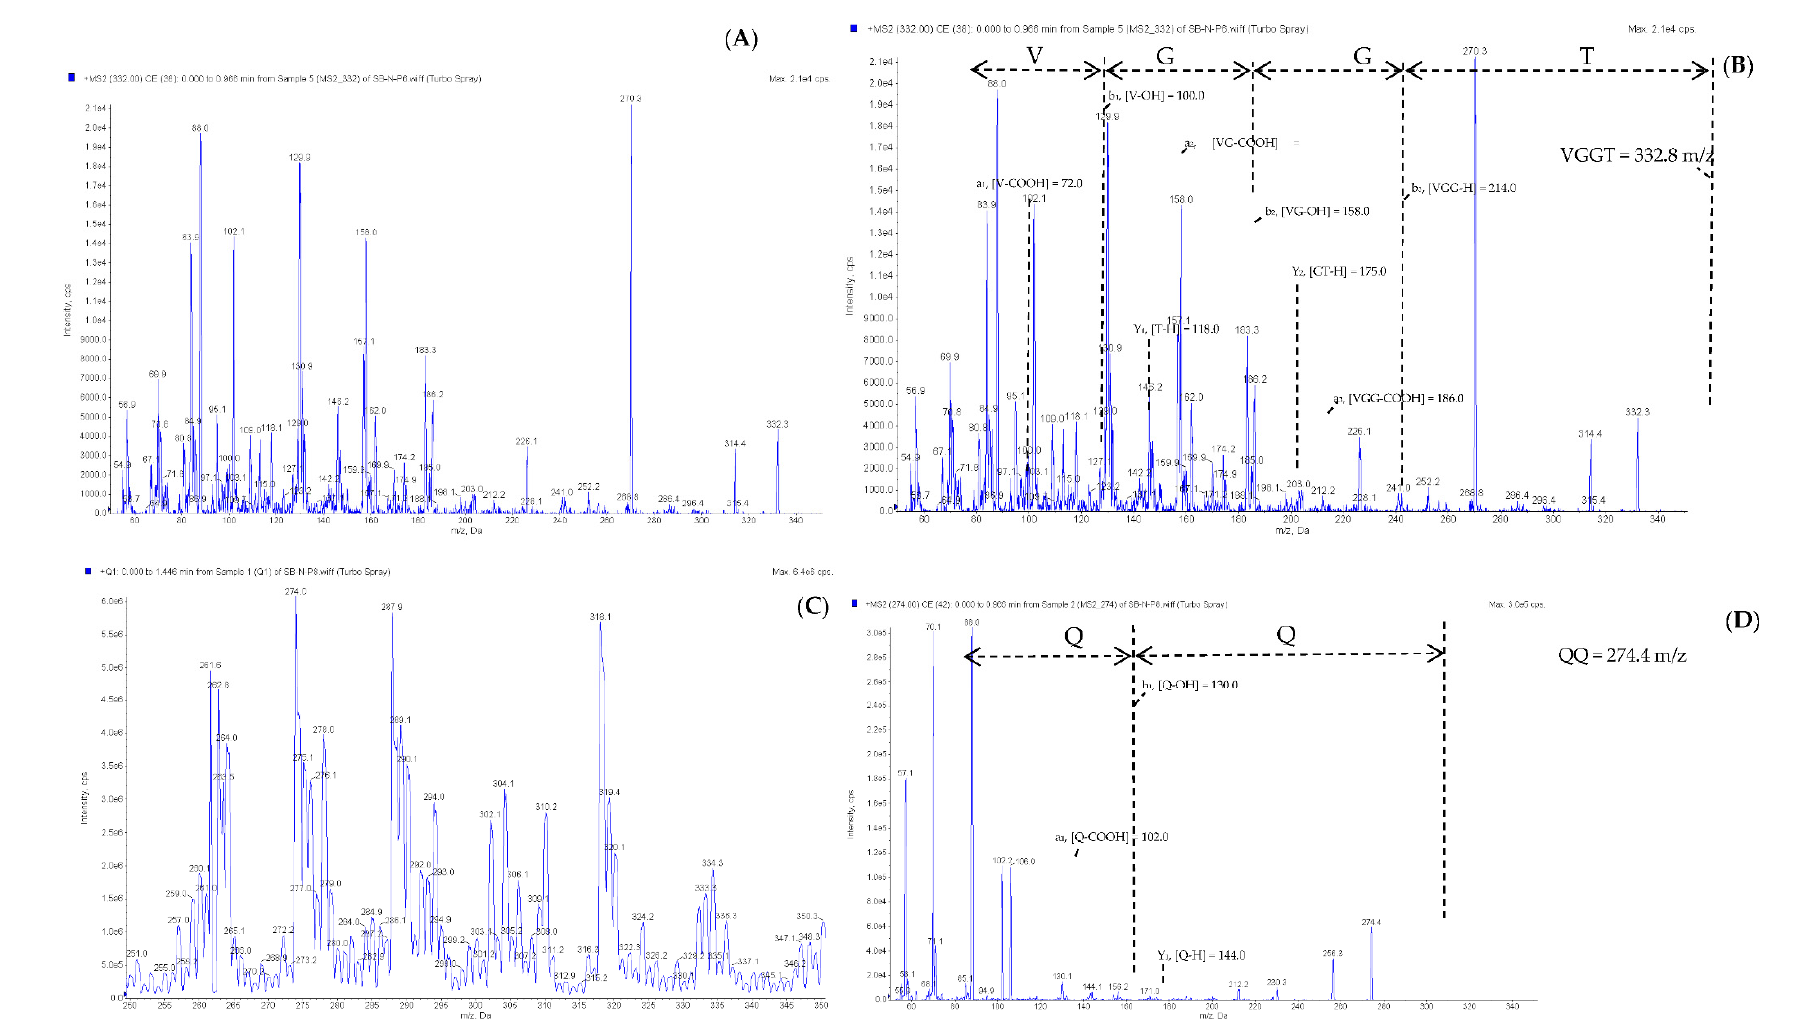
Figure A2. Identification of molecular mass and amino acid sequence of the peak E 6 and E 8 from F-HHP + PN6-PP by ESI/MS/MS. ( A , B ) the MS/MS spectra of peptide VGGT ( m / z 332.8). ( C , D ) the MS/MS spectra of peptide QQ ( m / z 274.0).